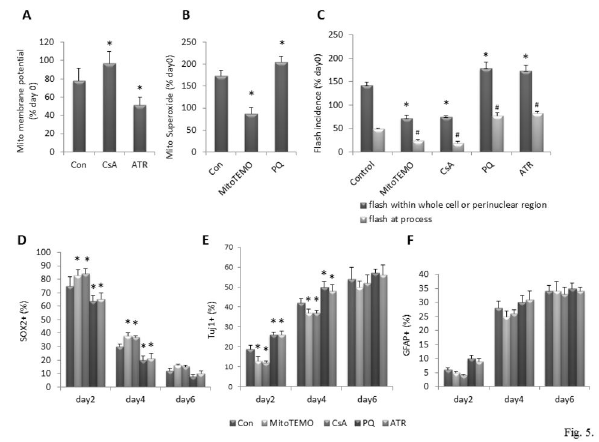
Figure 5. Mitochondrial superoxide flashes promote NPC differentiation. (A) Mitochondrial membrane potential in differentiated cells at day 2. Cells were treated with 100 nM CsA, 1µM ATR or vehicle at the time of growth factor removal. Values are expressed as a percentage of the mean of the control condition in NPCs (day 0). *p<0.05 compared to the control value in cells (day 2). (B) Mitochondrial superoxide in differentiated cells at day 2. Cells were treated with 1µM Mito- Tempol (MitoTEMO), 1µM PQ or vehicle at the time of growth factor removal. Values are expressed as a percentage of the mean of the control condition in NPCs (day 0), *p<0.05 compared to the control value in cells (day 2). (C) Superoxide flash incidence in differentiated cells at day2. Cells were treated with CsA, ATR, Mito-Tempol and PQ as indicated in A and B. Values are expressed as a percentage of the mean of the control condition in NPCs (day 0); Perinuclear or whole cell flash: *p<0.05 compared to the control value in cells (day 2); Flash at process: #p<0.05 compared to the control value in cells (day 2). (D, E and F) Percentage of NPCs, neurons and astrocytes at different days of differentiation. NPCs, neurons and astrocytes were identified by antibodies against Sox2, Tuj1 and GFAP at different days after differentiation. Total number of cells was counted by counterstaining nuclei with DAPI. n = 4 separate experiments performed on NPCs cultured from 4 pregnant mice. *p<0.05 compared to the control value of each individual